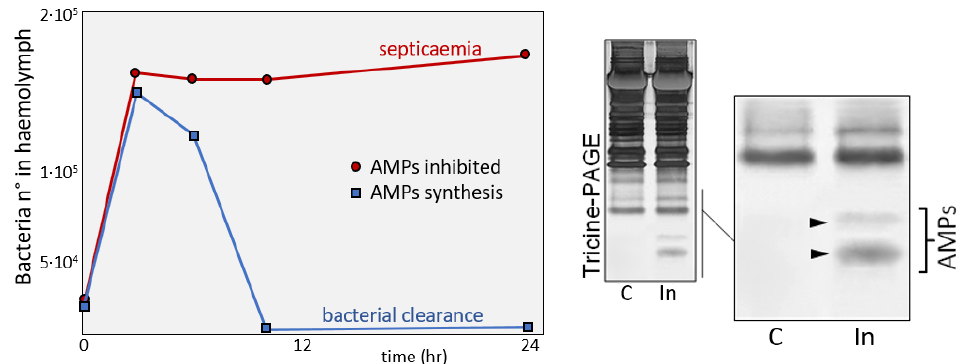
Figure 8. ( Left ) effects of AMPs synthesis after bacterial infection; insect larvae when inoculated with bacteria show an efficient bacterial clearance by means of newly synthesized AMPs (blue line). If the infection was carried out in the presence of inhibitors of protein synthesis (red line), AMPs were absent, and the larva showed symptoms of septicemia disease. ( Right ) Electrophoretic analysis of hemolymph samples from not infected (C) and infected (In) G. mellonella larvae. Arrowheads indicate the presence of two low molecular mass bands in the hemolymph from immunized larvae, (from [99]).